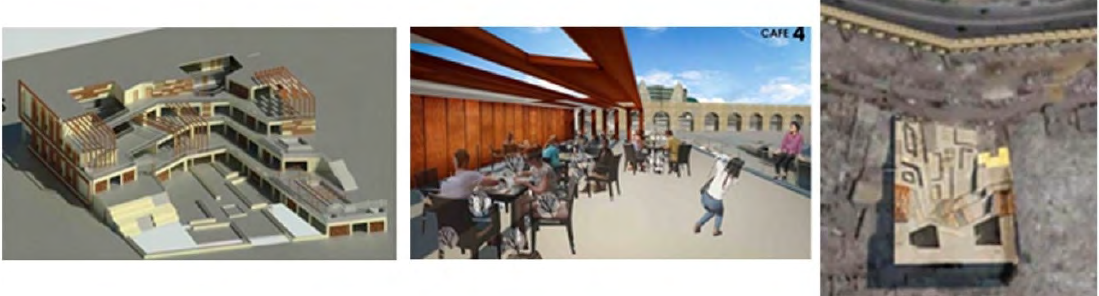
Figure 16. Showing all the floors and spaces directed towards the Wall of “Magra El Oyoun” (“Amr Aly’s” Project.)